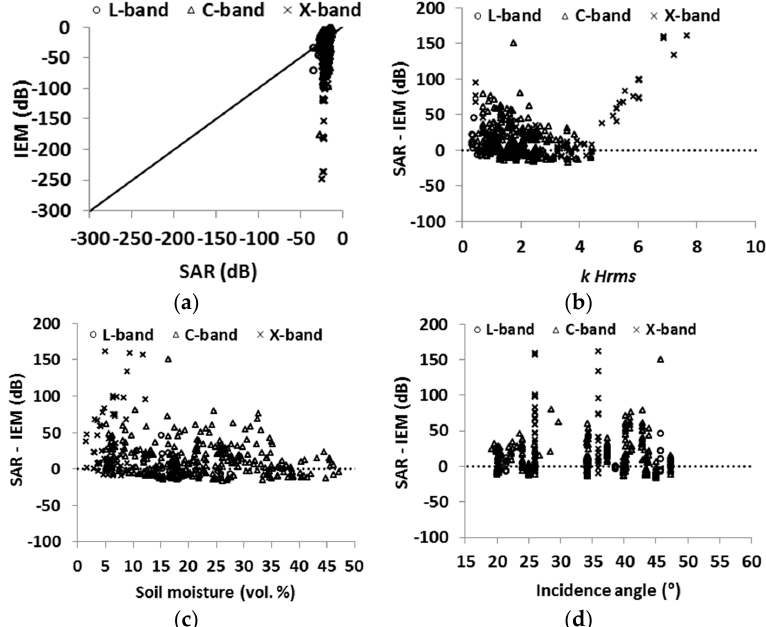
Figure 8. Comparison between backscattering coefficients derived from SAR images and those estimated from IEM at HV polarization using GCF. ( a ) IEM simulations vs. SAR data; ( b ) difference between SAR signal and IEM vs. soil roughness ( kHrms ); ( c ) difference between SAR signal and IEM vs. soil moisture ( mv ); ( d ) difference between SAR signal and IEM vs. incidence angle.